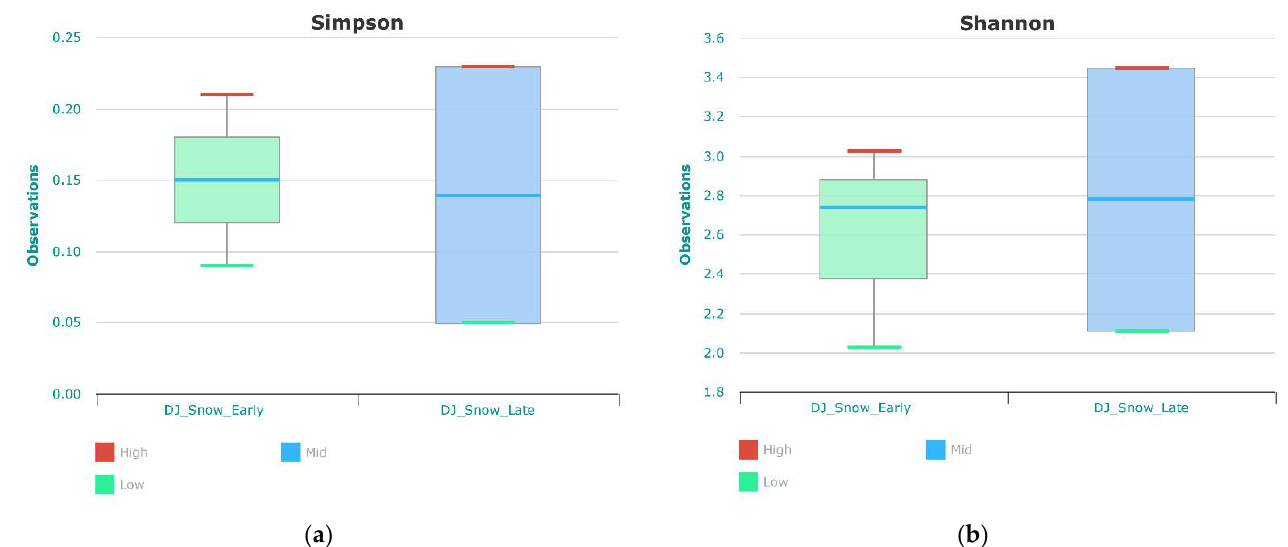
Figure 2. Comparison of the diversity indices of 16S from early season fresh snowfall samples DJS-1, DJS-2, and DJS-3 with the late season samples DJS-4 and DJS-5. ( a ) shows the Simpson diversity index during early season and late season snowfall while ( b ) shows the Shannon diversity index during early season and late season snowfall.